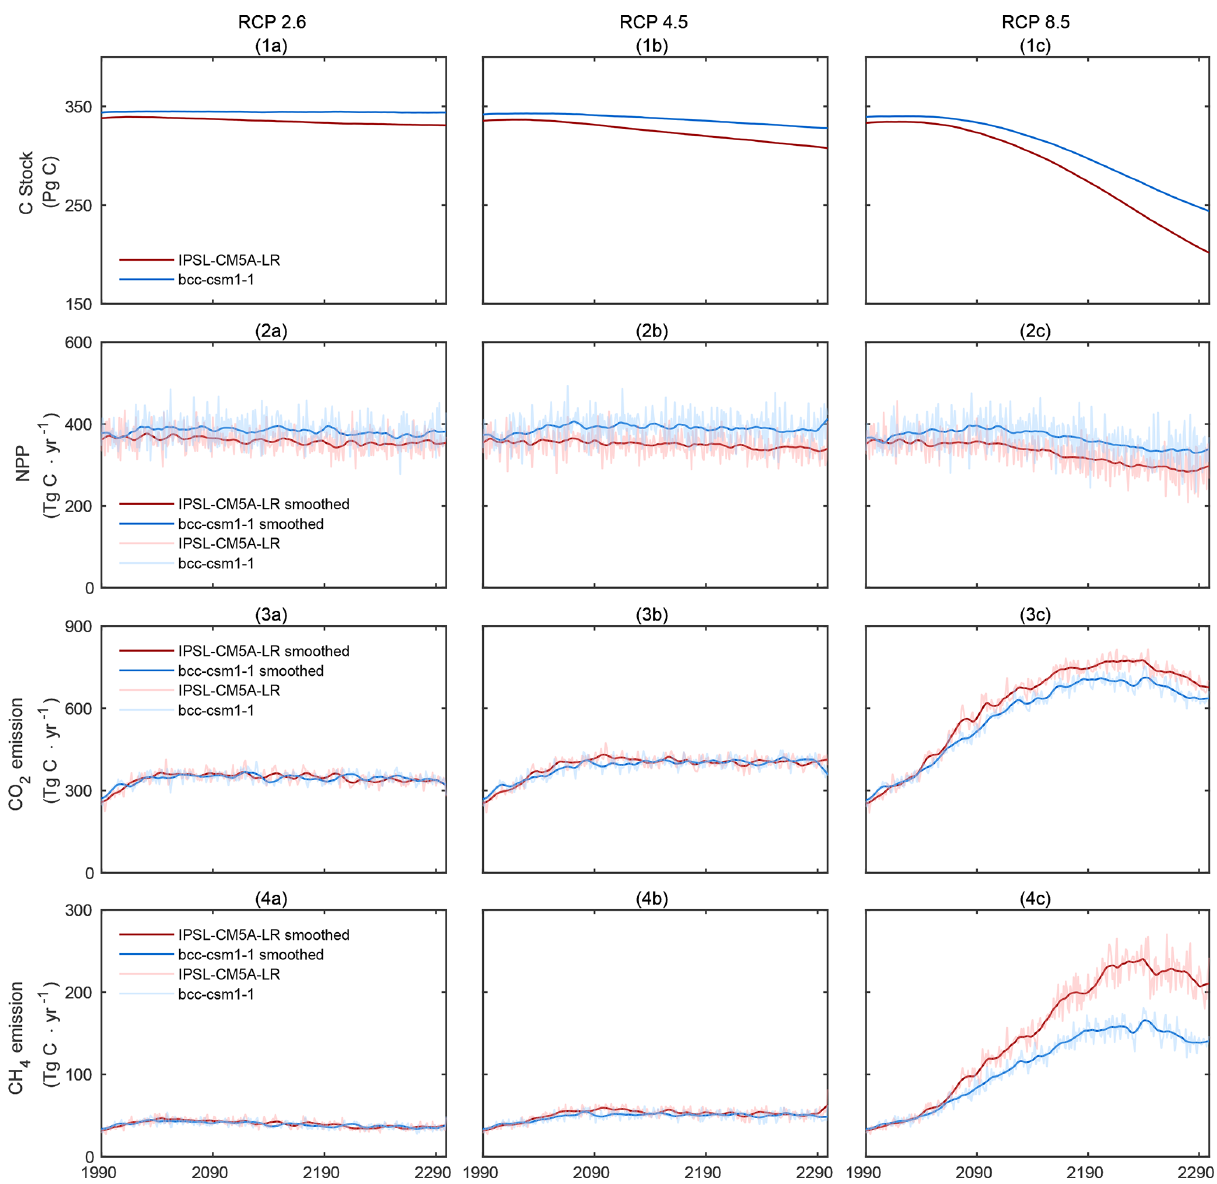
Figure 6. Time series of pan-Arctic peatland C storage (vegetation and soil, Pg C), NPP (TgCyr − 1 ), CO 2 emissions from soil heterotrophic respiration (TgCyr − 1 ) and CH 4 emissions (TgCyr − 1 ) during